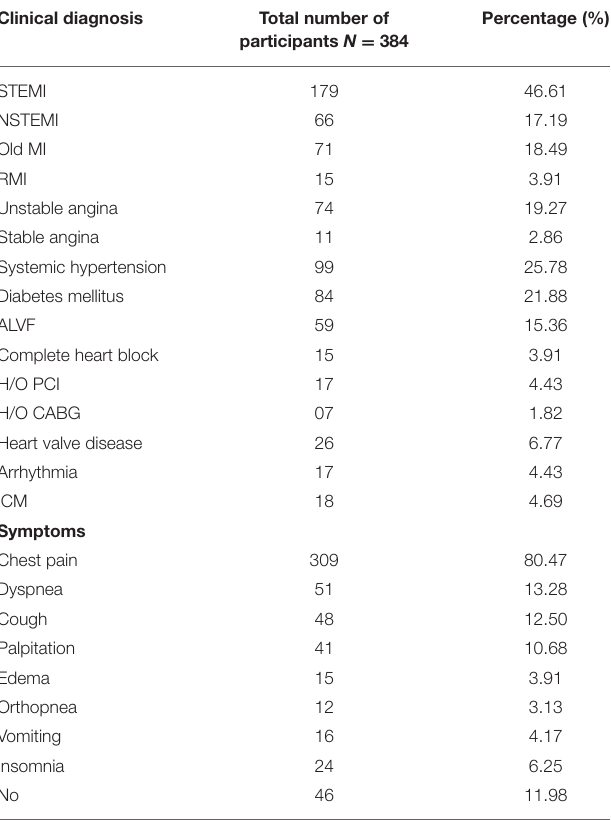
TABLE 2 | Clinical diagnosis and cardiac symptoms of the respondents, ( N = 384). Clinical diagnosis